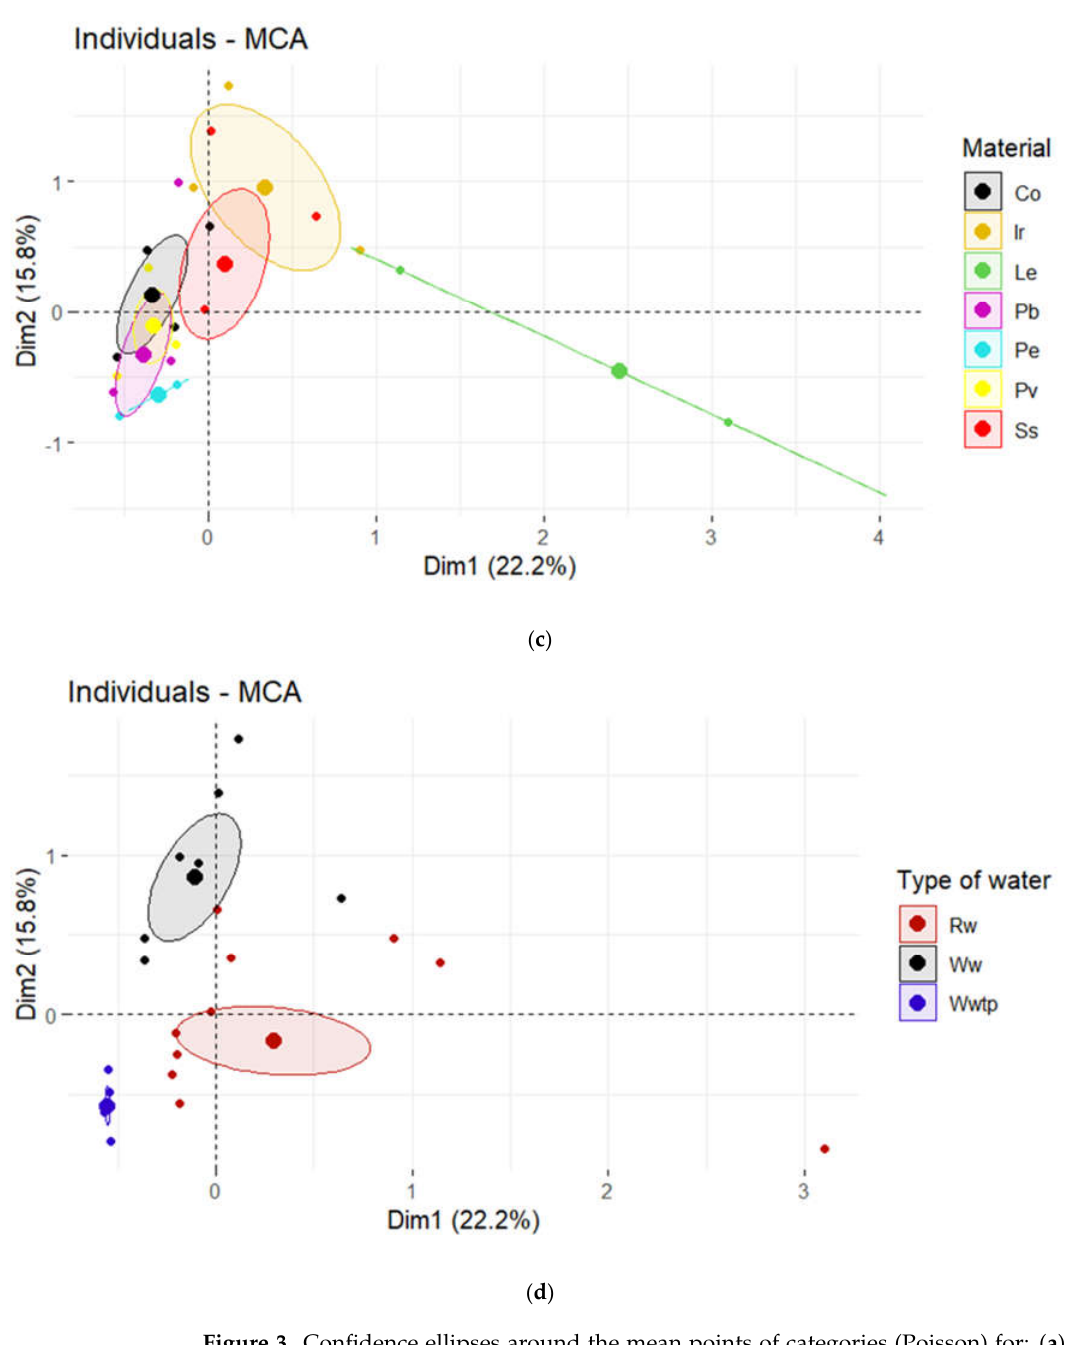
Figure 3. Confidence ellipses around the mean points of categories (Poisson) for: ( a ) equipment; ( b ) legislative compliance; ( c ) pipe material; and ( d ) type of water.